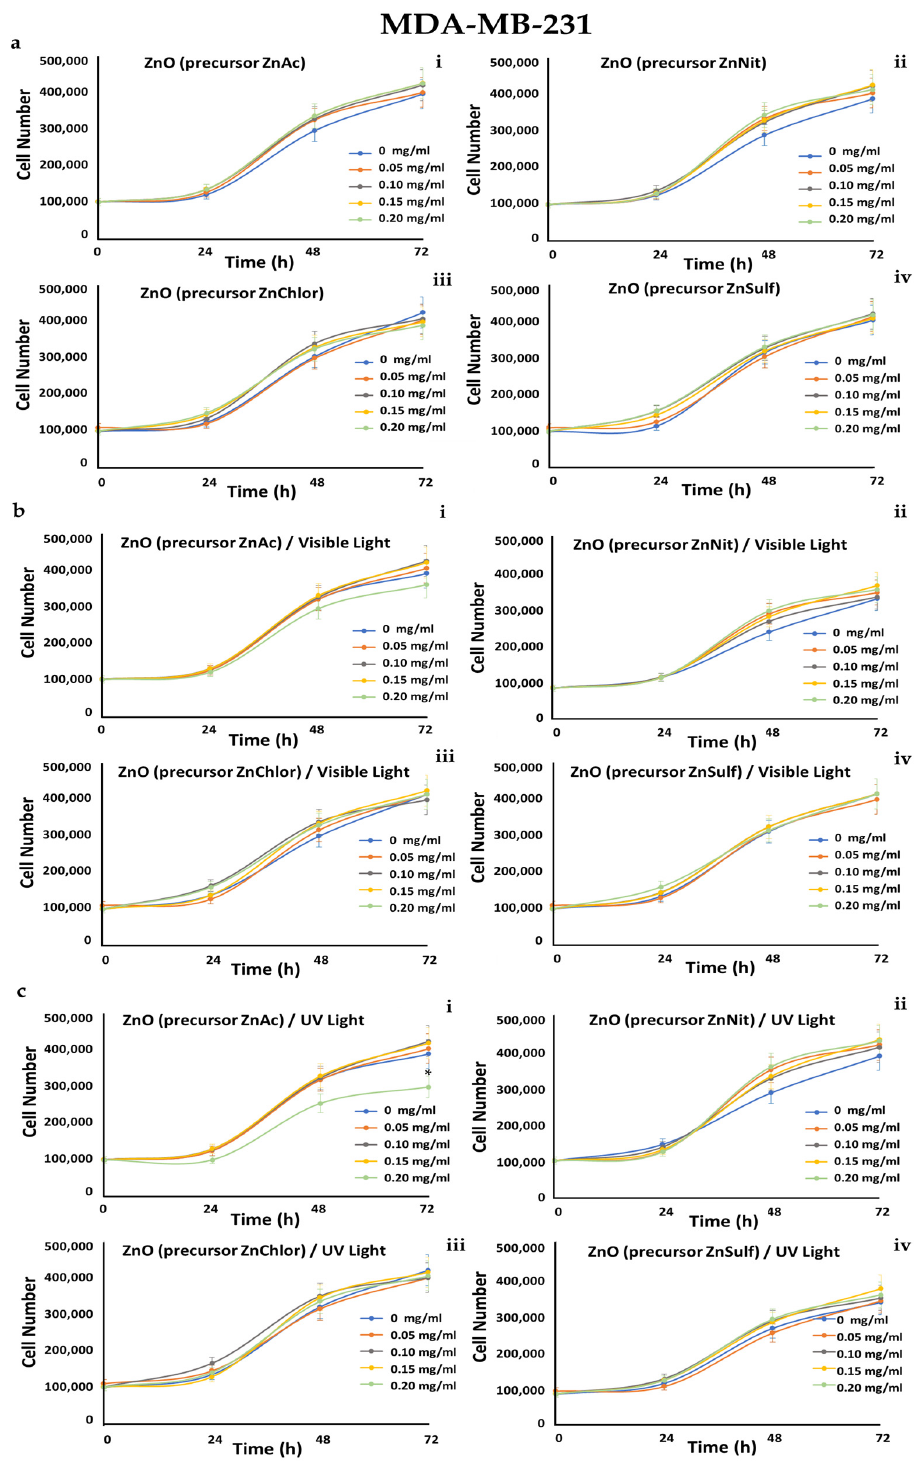
Figure 20. Growth rates of MDA-MB-231 cell line in the presence of ( a ) zinc acetate dehydrate (ZnAc), zinc nitrate hexahydrate (ZnNit), zinc chloride (ZnChlor), zinc sulphate heptahydrate (ZnSulf). ( b ) Photo-activated with visible light ZnAc, ZnNit, ZnChlor, and ZnSulf. ( c ) Photo-activated with UV light ZnAc, ZnNit, ZnChlor, and ZnSulf. There is not any significant effect on cell proliferation except from the photo-activated with UV light ZnAc that decreased the cell population by 25% at the concentration of 0.2 mg/mL. p < 0.05 was considered statistically significant.